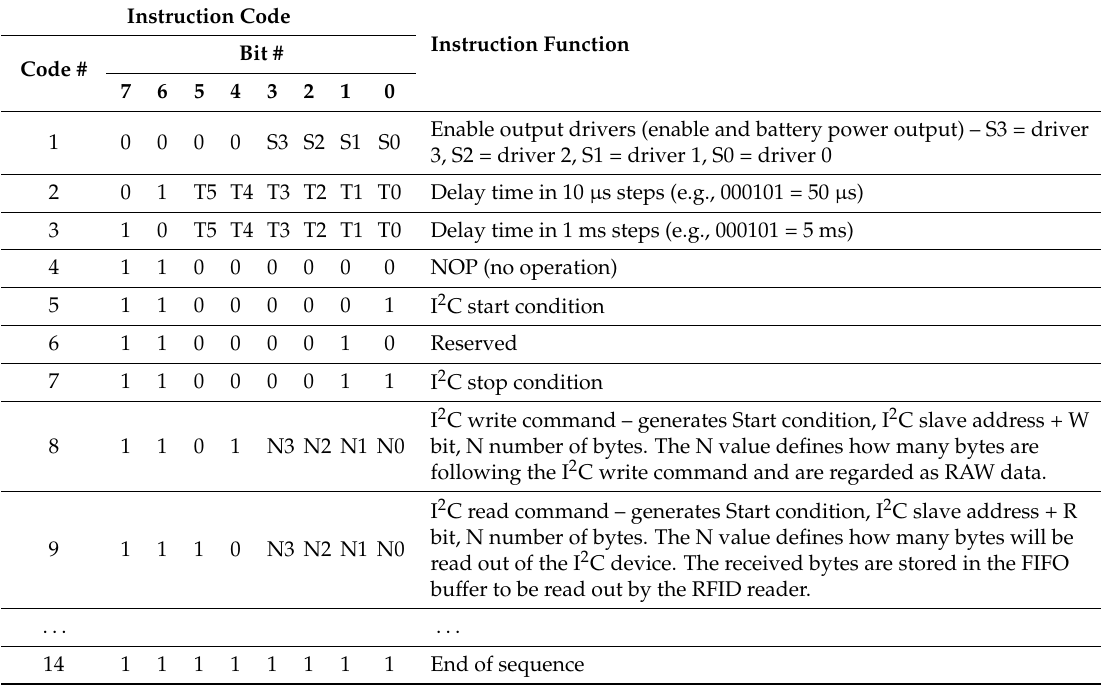
Table 1. List of micro-program commands (shortened), available to the